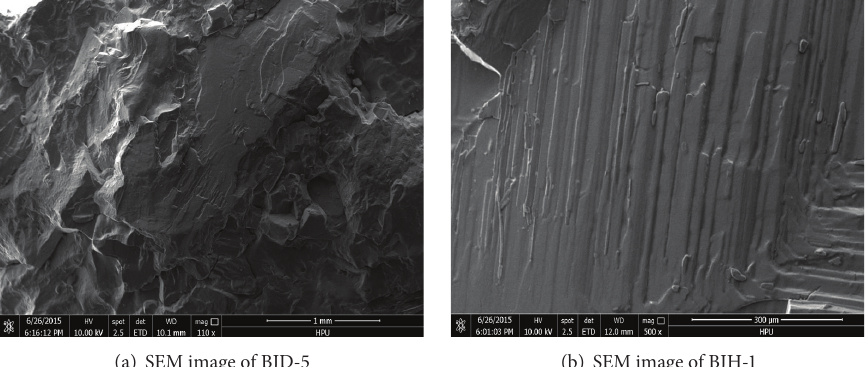
Figure 11: Comparison of SEM images between BJD-5 and